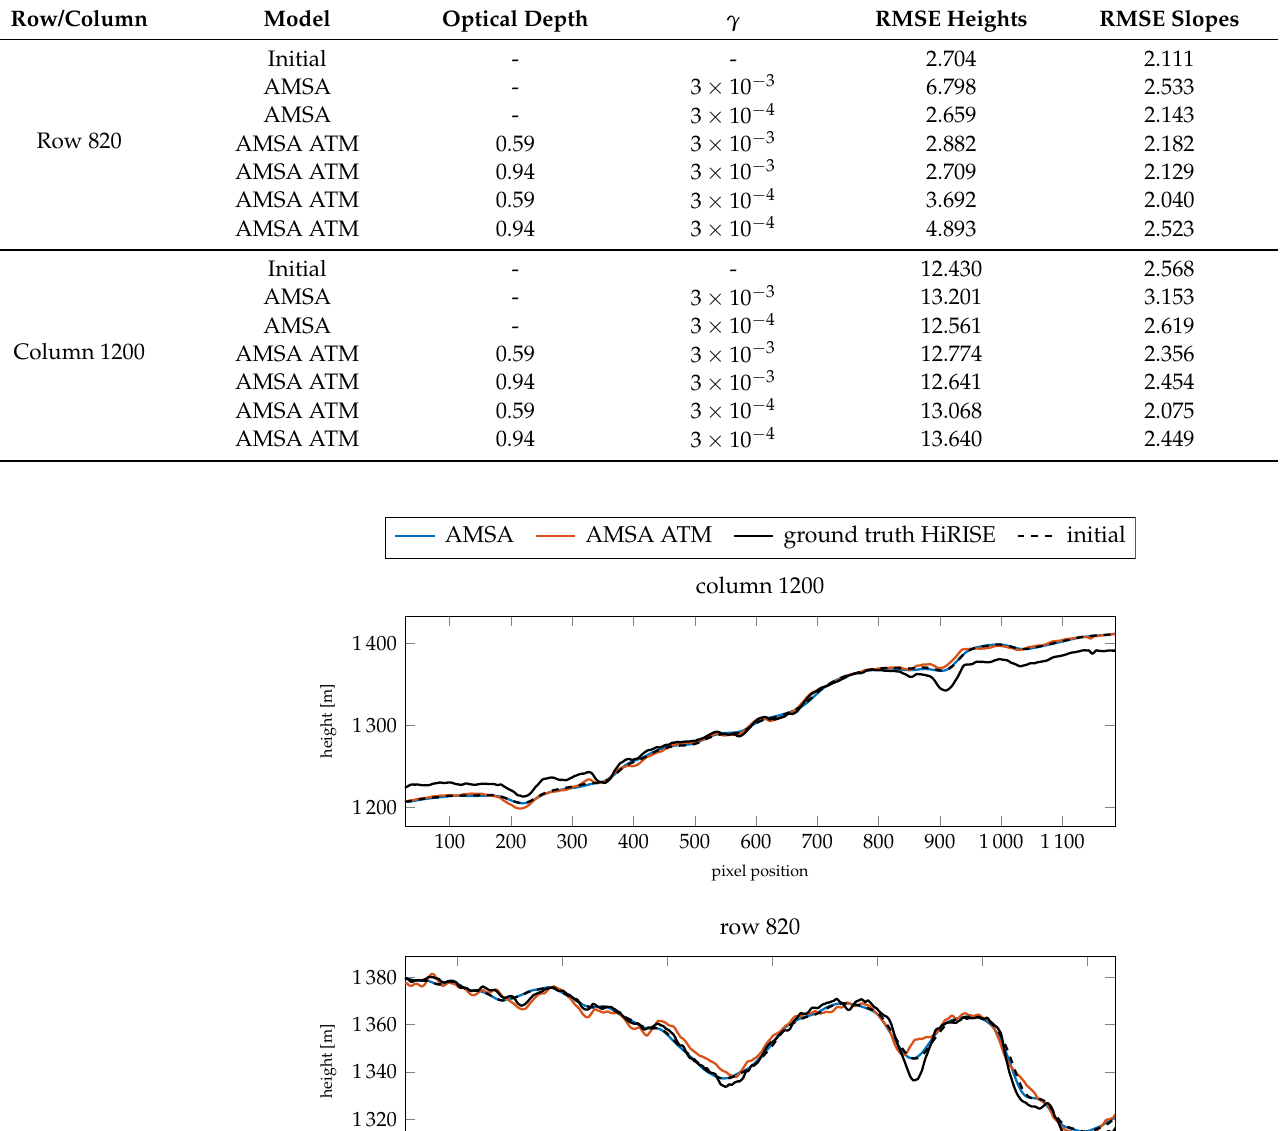
10 − 3 is the best value for the AMSA model ×